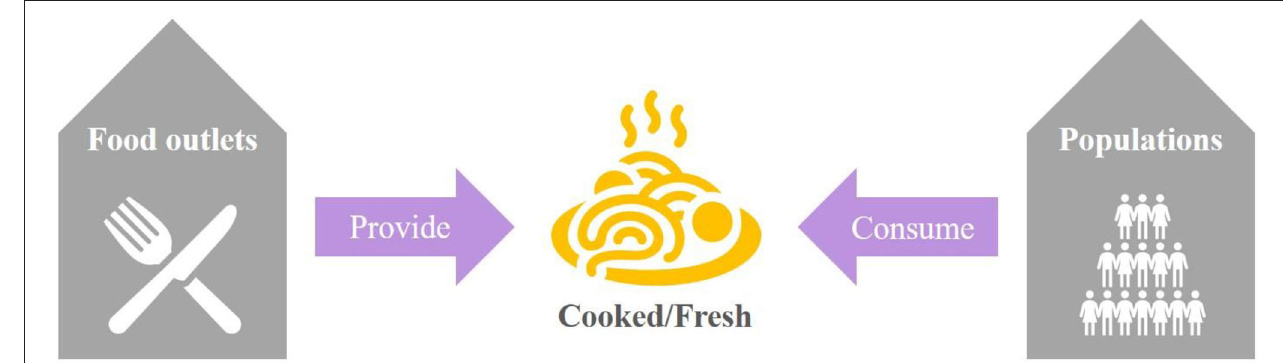
FIGURE 1 | The fundamental fact of the relationship between food environment and